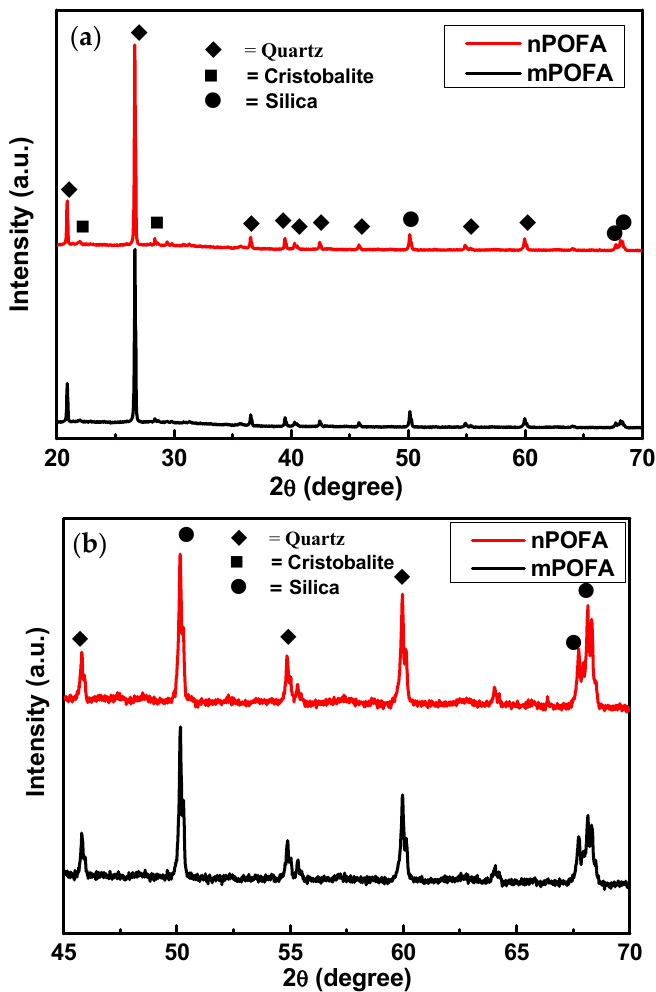
Figure 4. XRD of micro- and nano-POFA at 2 θ = 20–70° ( a ) and 2 θ = 45–70° ( b ).